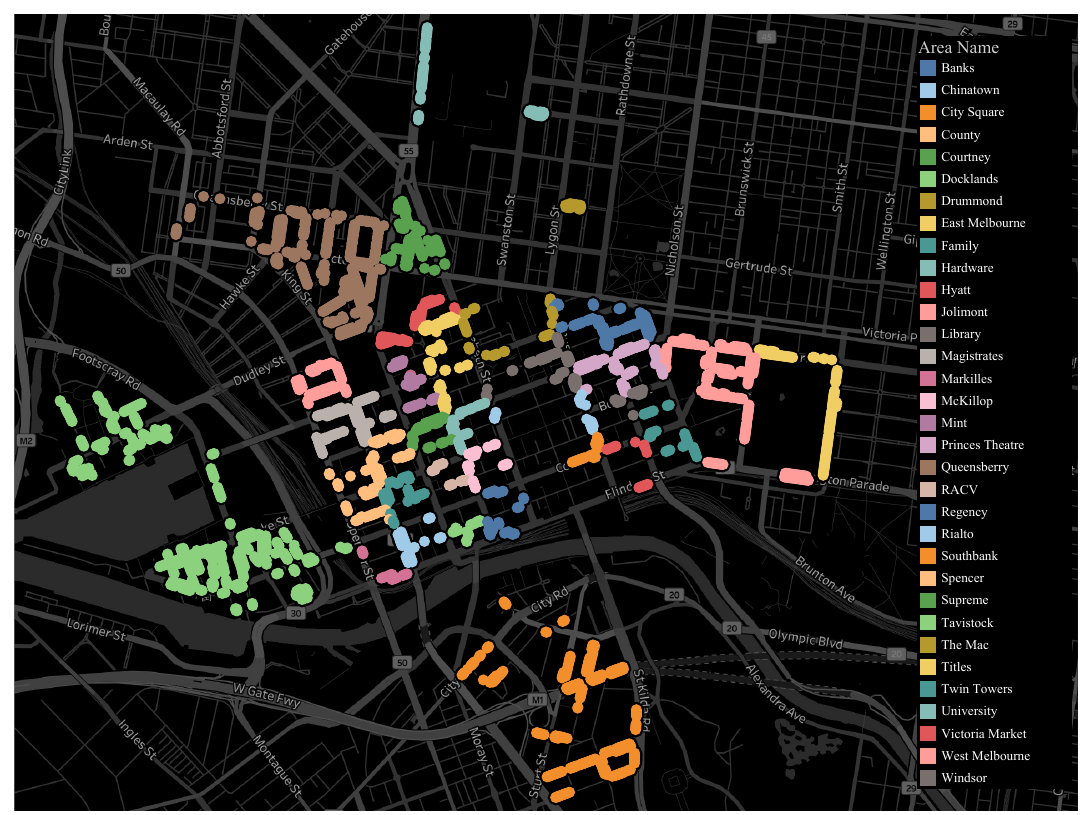
Figure 4. A map of the distribution of parking bays and areas in Melbourne. Table 1. Features of the Melbourne parking bay dataset (dataset II). Feature